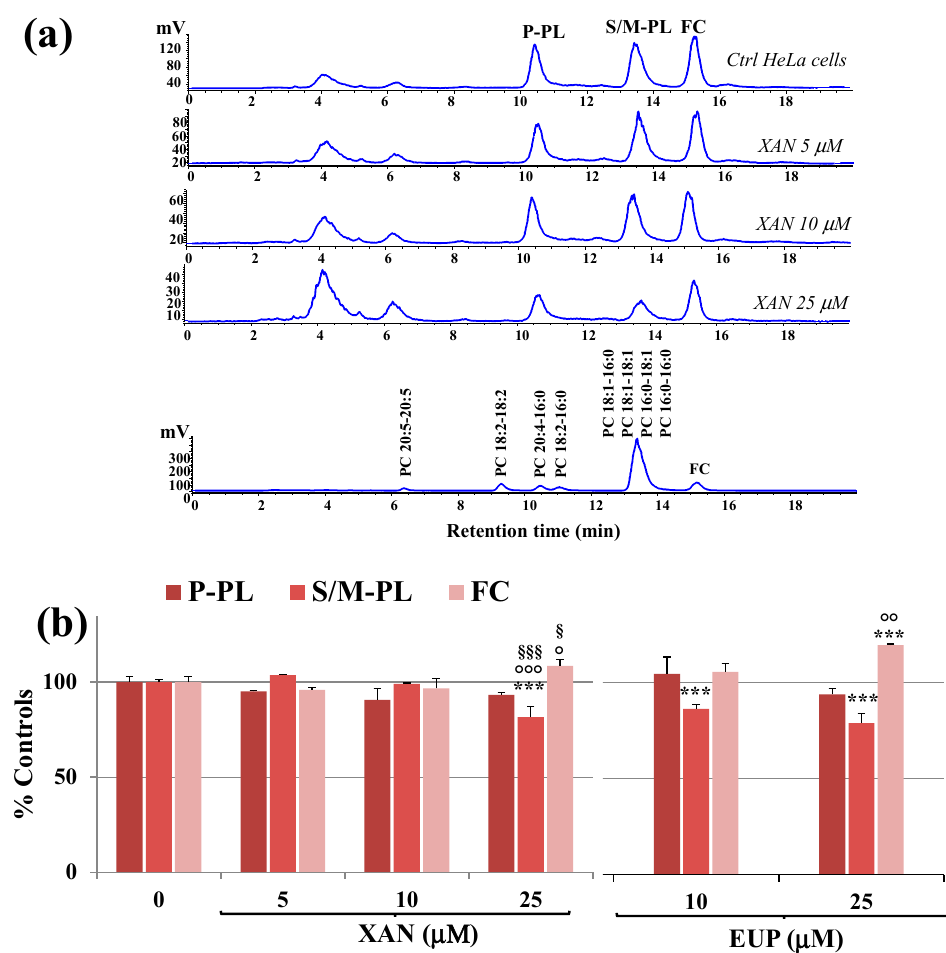
Figure 6. ( a ) Chromatographic profile obtained by HPLC-ELSD analysis at 0.7 mL/min of polyunsaturated phospholipids (P-PL), saturated/monounsaturated phospholipids (S/M–PL), and free cholesterol (FC), measured in control HeLa cells (0) and cells treated for 24 h with different amounts (5, 10 and 25 µ M) of xanthomicrol (XAN). A standard mixture of saturated/monounsaturated (mix PL: PC 16:0/16:0, PC 18:1/18:1, PC 16:0/18:1, PC 18:1/16:0) and polyunsaturated phosphatidylcholines (PC 16:0/18:2, PC 16:0/20:4, PC 18:2/18:2; PC 20:5/20:5) were used to assign the chromatographic region for each lipid class. ( b ) Values (% controls) of PL and FC measured in control and HeLa cells treated with XAN (5, 10 and 25 µ M) and the reference compound eupatilin (EUP) (10 and 25 µ M) [6]. Three independent experiments are performed, and data are presented as mean ± standard deviation (SD) ( n = 6). For each series: *** = p < 0.001 versus Ctrl; ◦◦◦ = p < 0.001, ◦◦ = p < 0.01, ◦ = p < 0.05 versus cells treated with XAN 5 µ M; §§§ = p < 0.001, § = p < 0.05 versus cells treated with XAN 10 µ M. Statistical significance of differences was assessed by One-way ANOVA and Bonferroni post